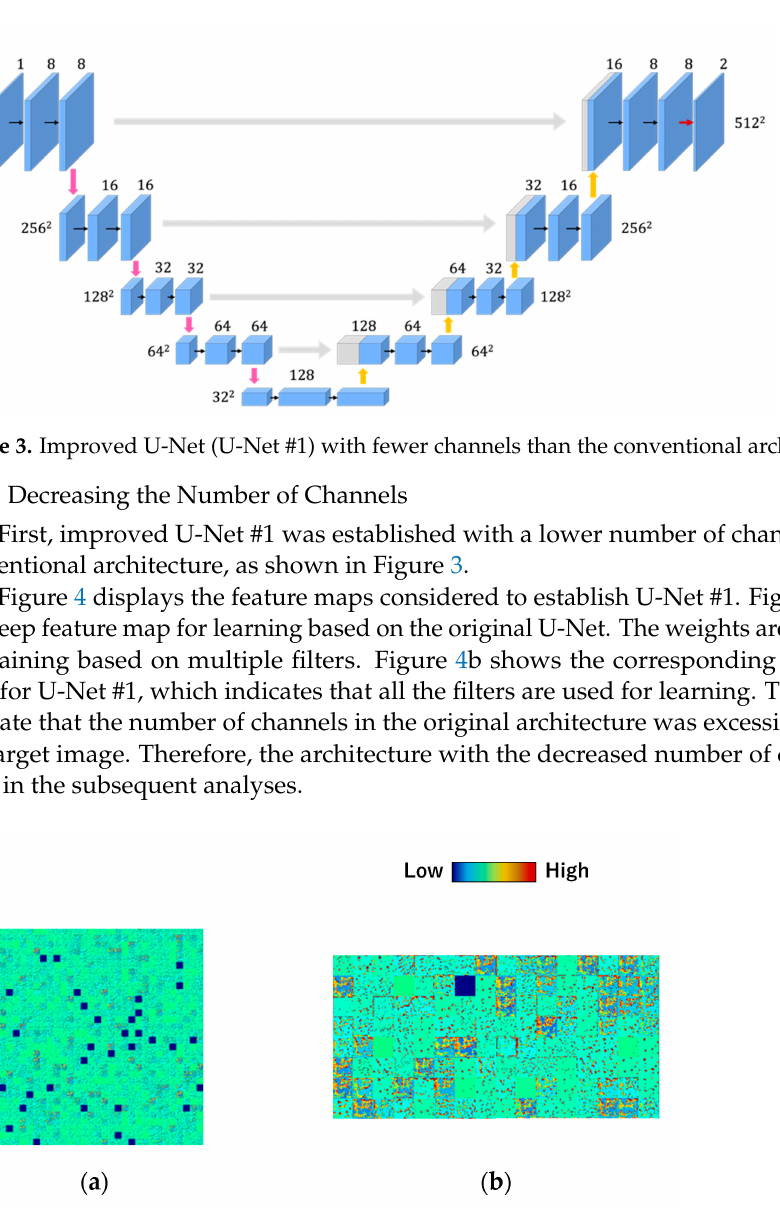
Figure 4. Feature maps of the deep layer ( a ) before (conventional U-Net) and ( b ) after (U-Net #1) the number of channels was